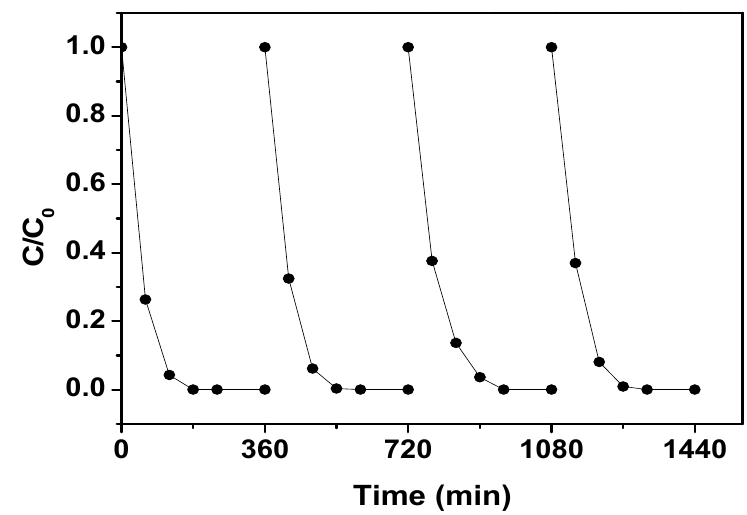
Figure 10. Reuse of 4% PANI/TiO 2 for degradation of MB under visible-light irradiation (MB = 5 μ M, catalyst dose: 0.8 g/L).